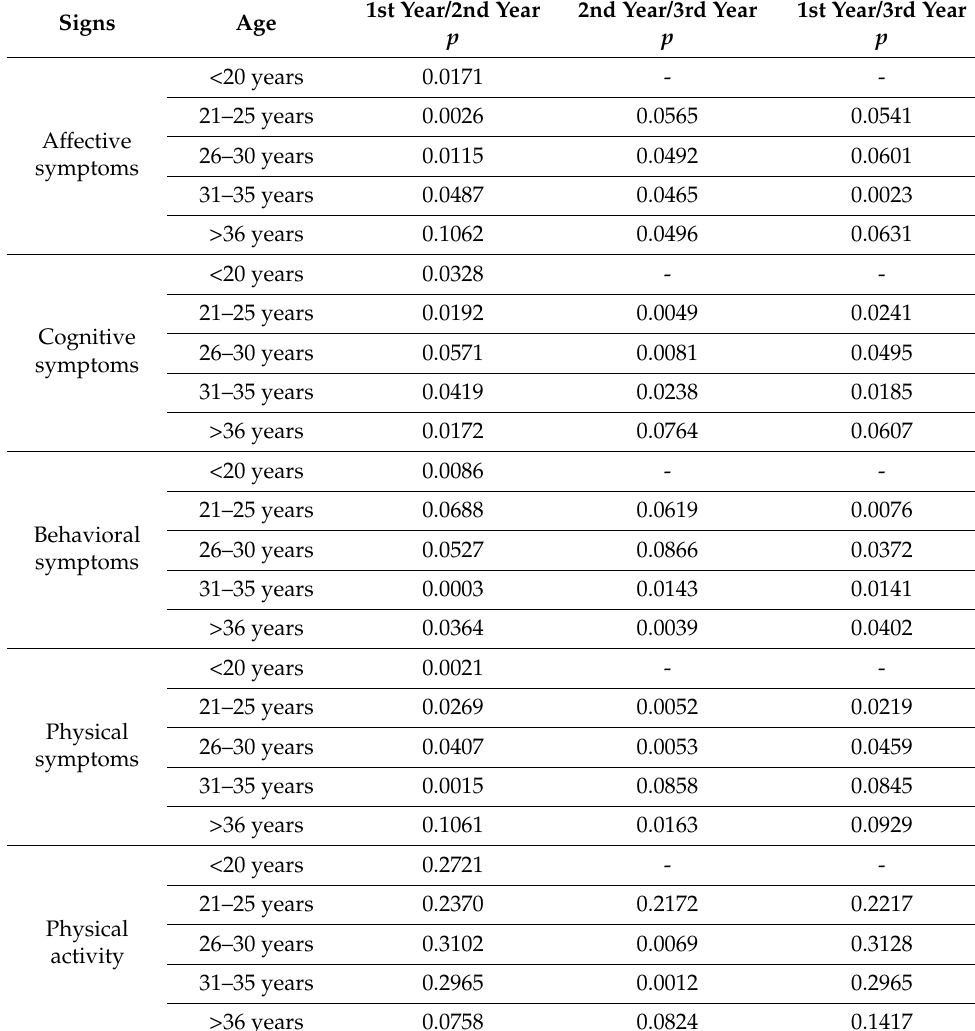
Table 3. Effects of age group on students’ symptoms between study years ( t